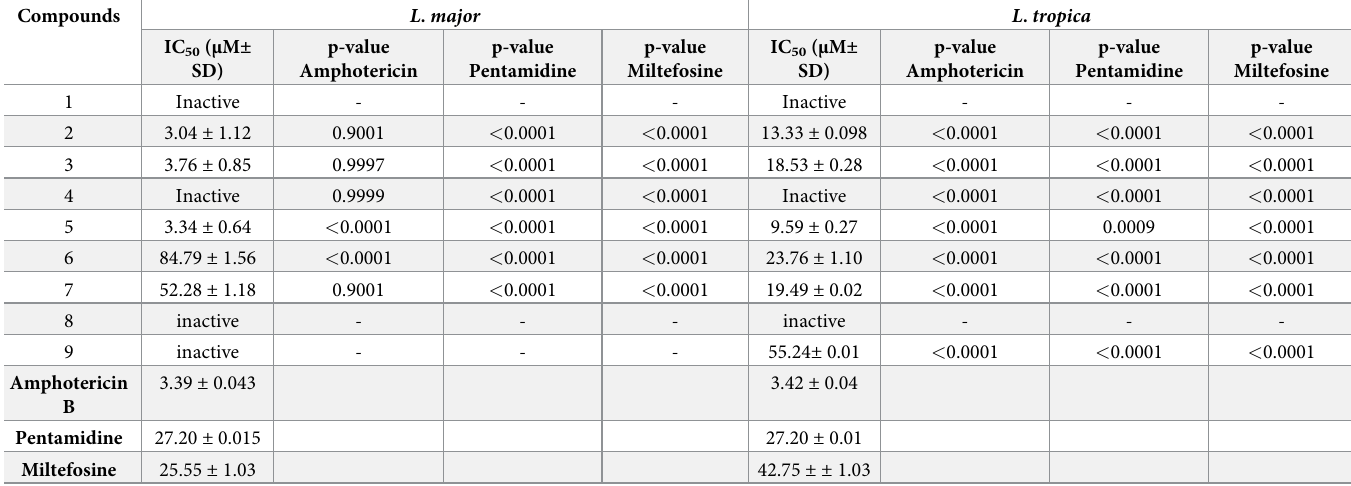
Table 3. Anti-leishmanial activity of compounds 1–9 against L . major and L . tropica